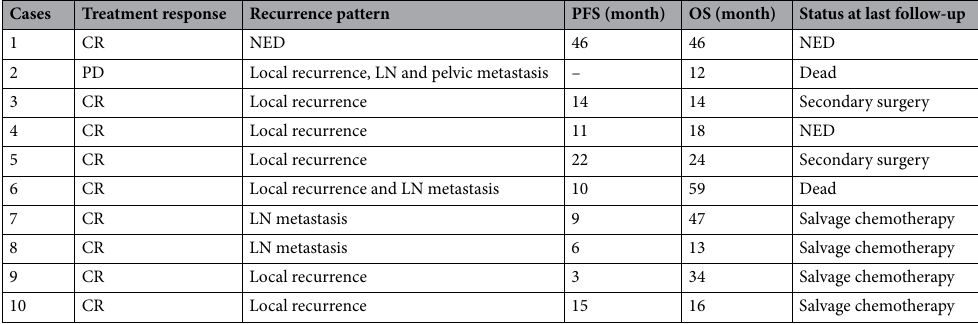
Table 2. Treatment outcomes of patients with clear cell carcinoma of the abdominal wall. CR complete response, PD progressive disease, PFS progression-free survival, OS overall survival, NED no evidence of